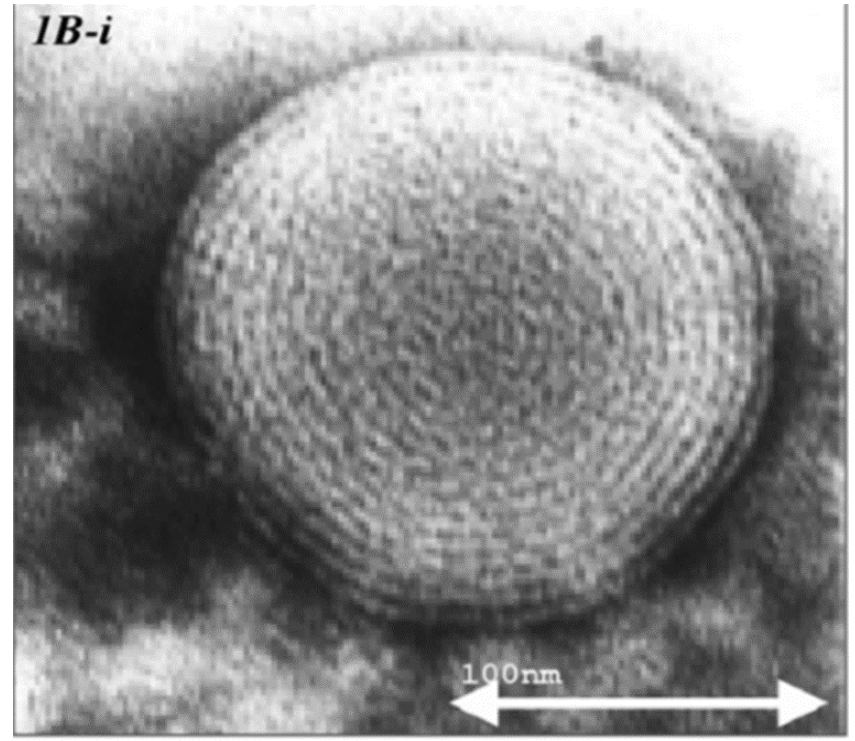
Figure 1. Transmission electron (TE) micrographs of multilamellar to the core minoxidil ethosomes. Reproduced from Reference [24] with permission.